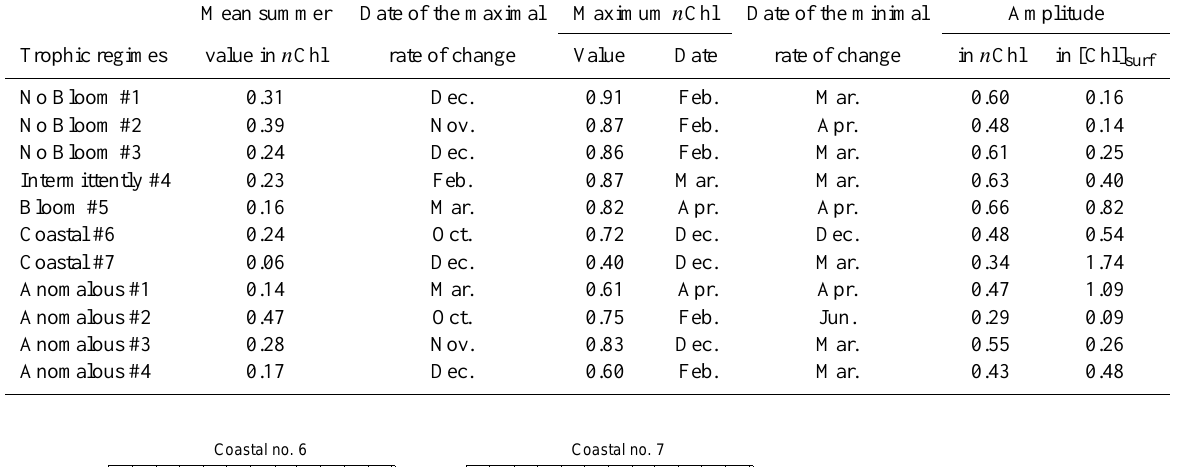
Table 1. Index on the trophic regimes’ mean time series (Fig. 2). Summer is defined from June to August, and the date of the maximal and/or minimal rate of change as the date of the highest and/or lowest first derivative of the mean time series of n Chl. Whereas the amplitude corresponds to the difference between the mean summer values and the annual maximum values of n Chl or [Chl] surf (see Sect. 3.2).